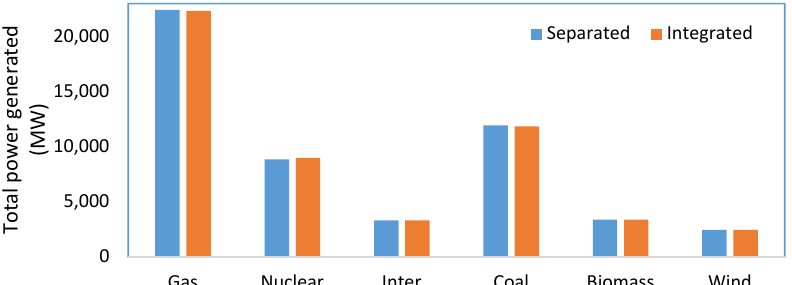
Figure 8. Pressure at node 14. Table 5. Commitment status of GFPPs in separated method.